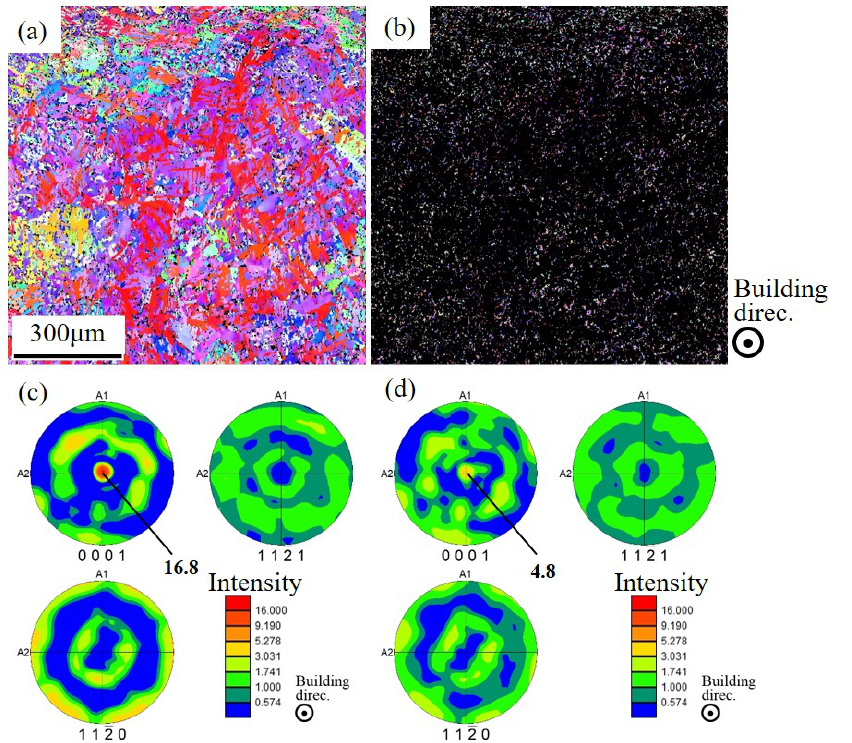
Figure 14. Inverse pole figure maps of as fabricated sample: ( a ) grain size >5 µ m ( b ) (cid:53) 5 µ m. ( c , d ) Corresponding pole figures of ( a , b ),